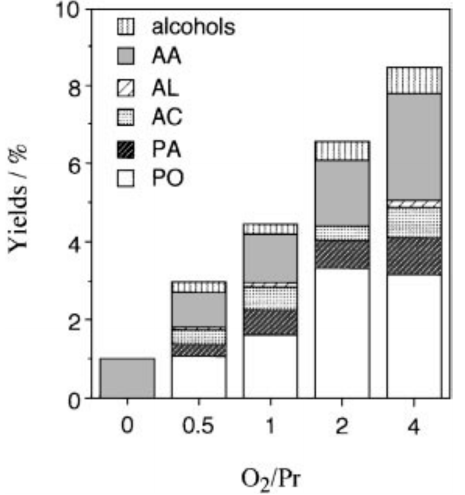
Figure 8. The influence of product yields on the oxygen/propylene ratio in the photo-epoxidation of propylene over Mg-loaded silica. Propylene: 30 μ mol; irradiation time of 2 h. Abbreviations: propylene oxide (PO), acetaldehyde (AA), propionaldehyde (PA), acetone (AC), acrolein (AL), and alcohols (methanol, ethanol, and propan-2-o1). Reproduced with permission from [20] .